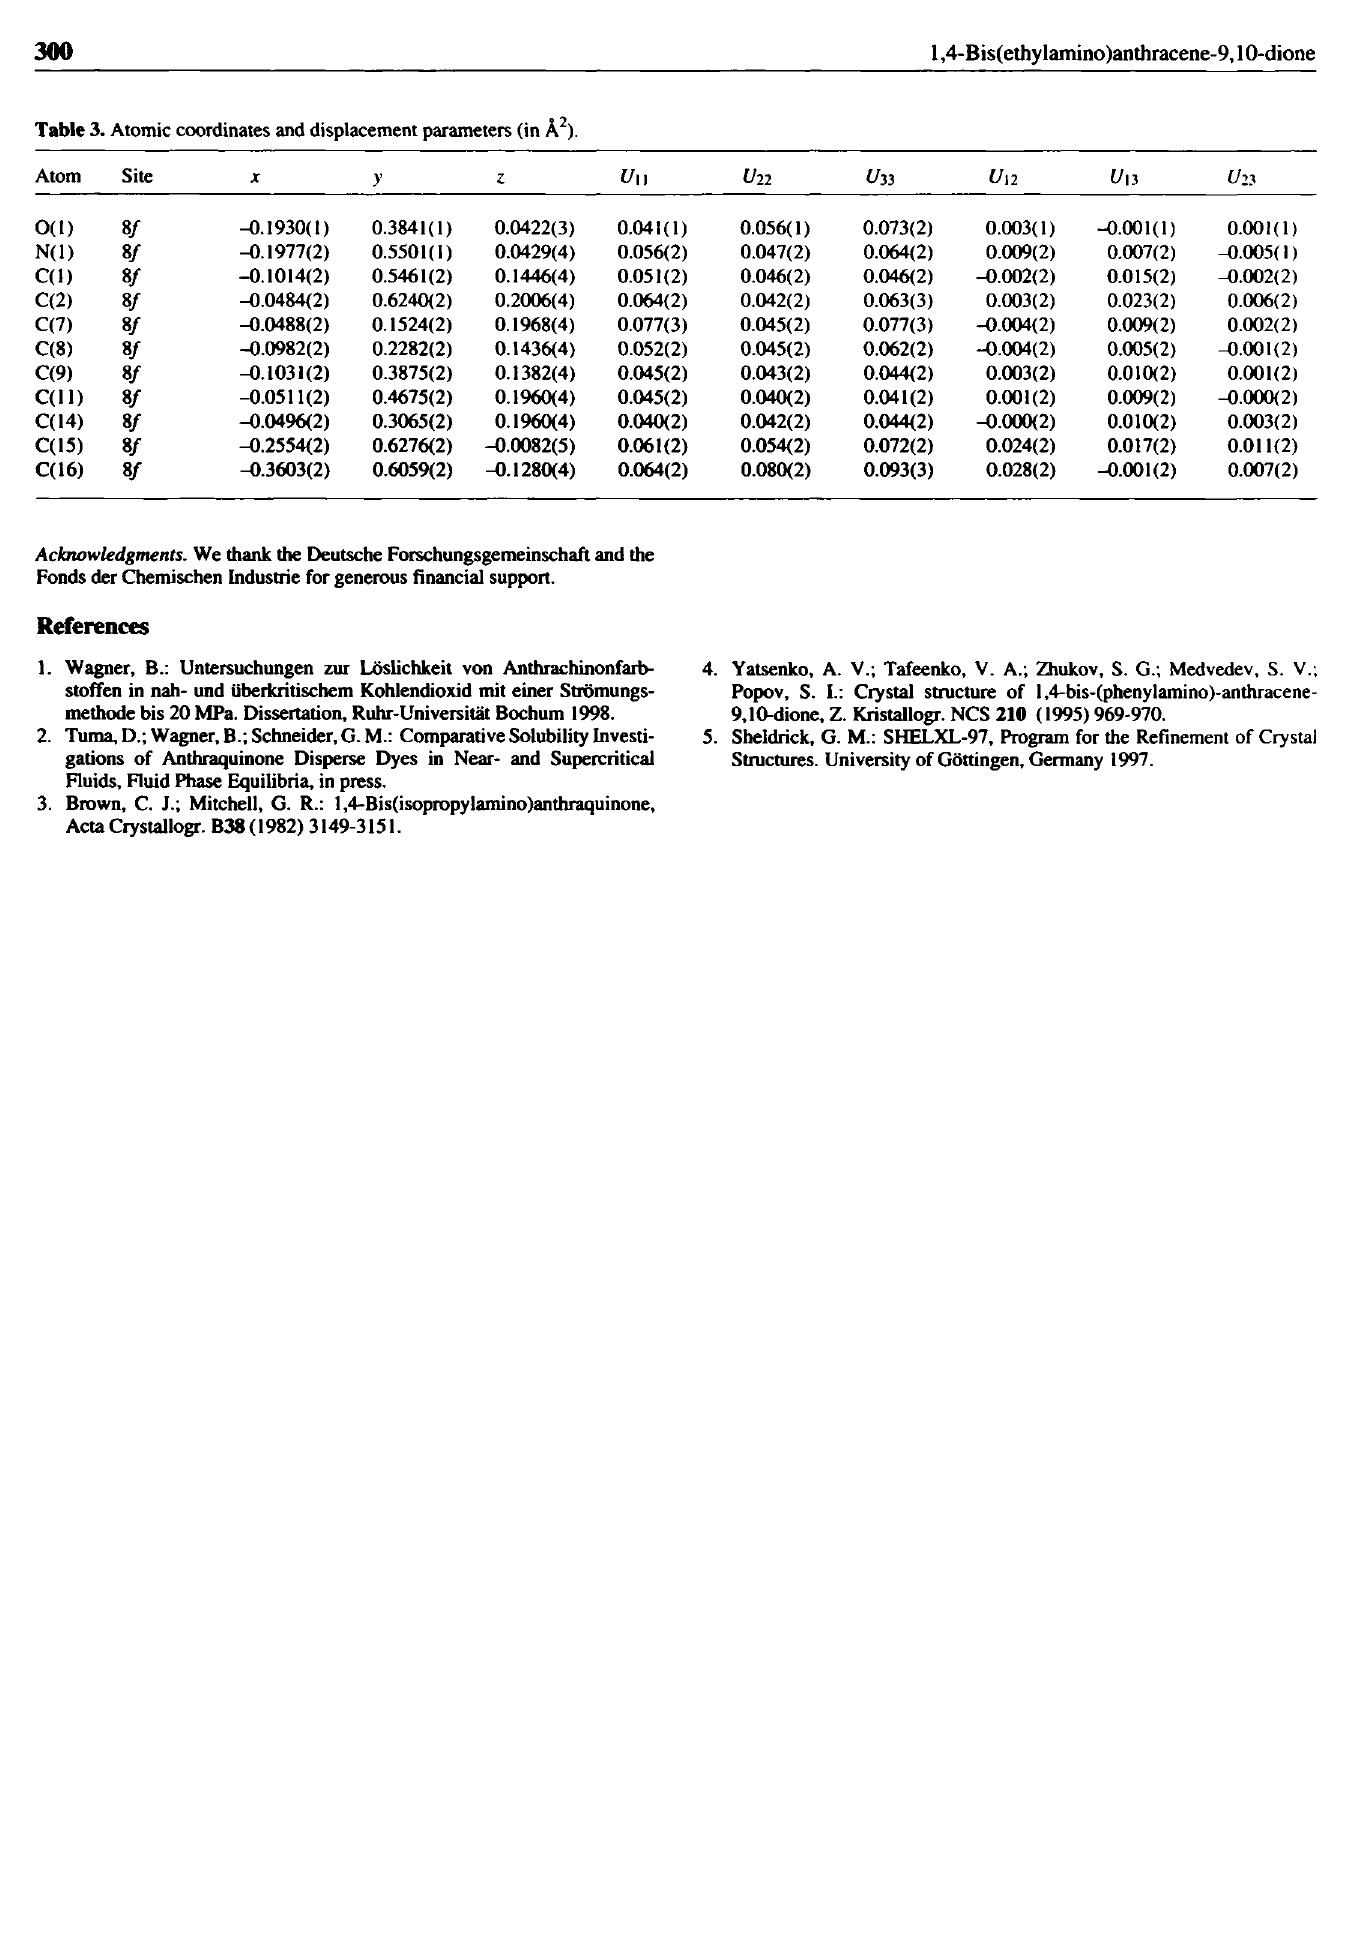
Table 3. Atomic coordinates and displacement parameters (in A 2